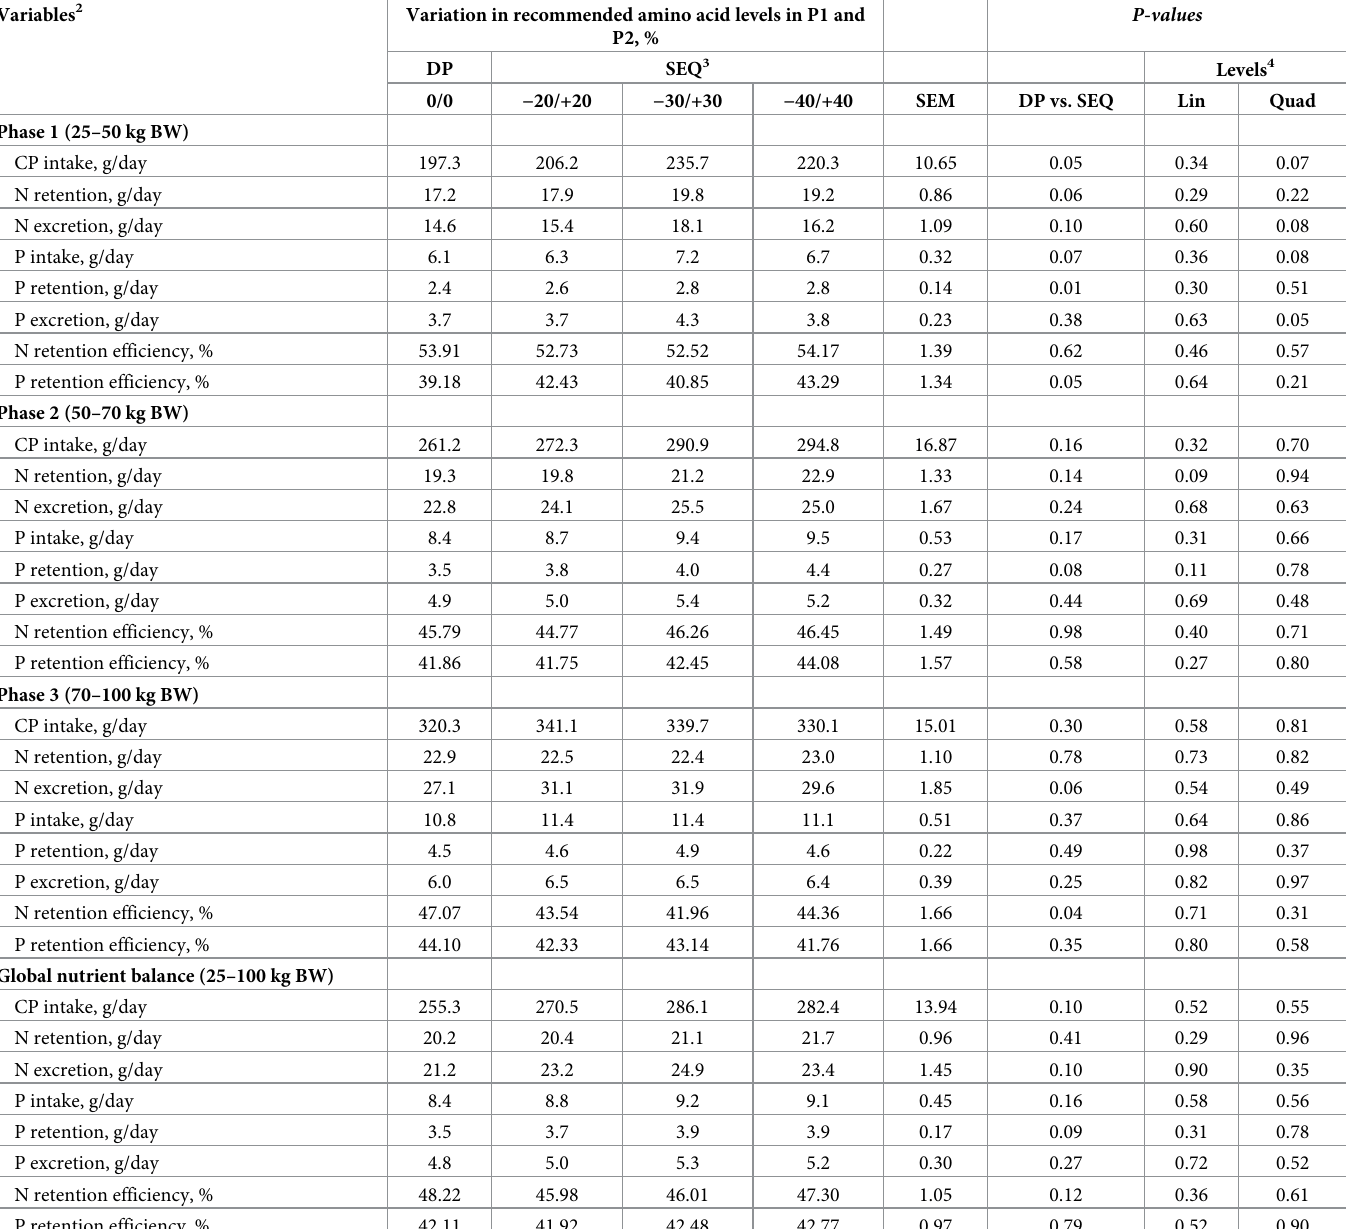
Table 4. Nutrient balance of pigs in a daily feeding program (DP) or in a sequential feeding program (SEQ) with different levels of variation in amino acid (AA) concentration throughout the day 1 . Variables